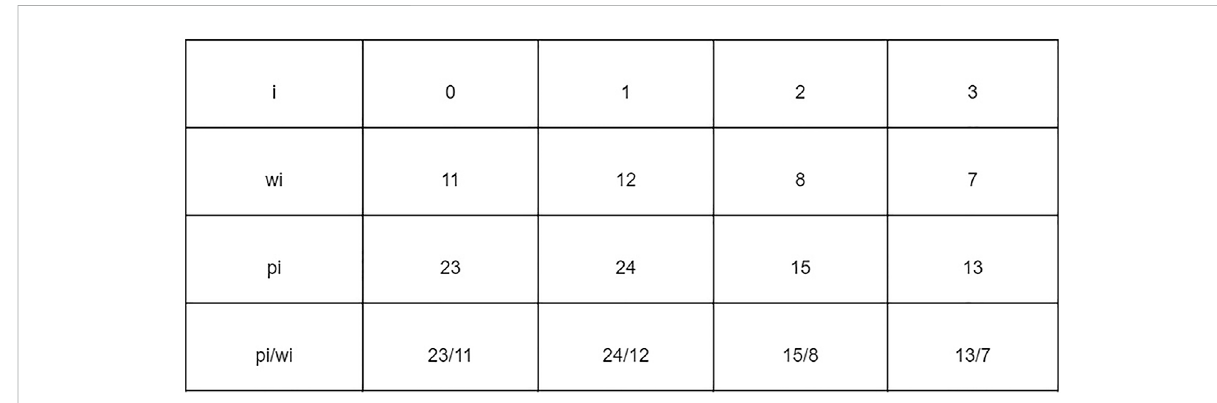
FIGURE 4 Data with weight and pro fi t.